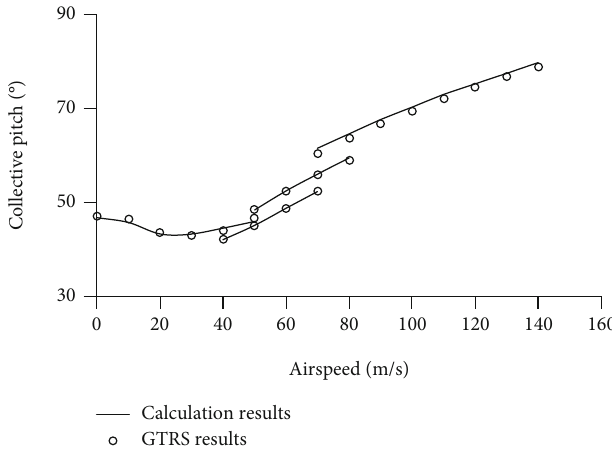
Figure 2: Collective pitch trim